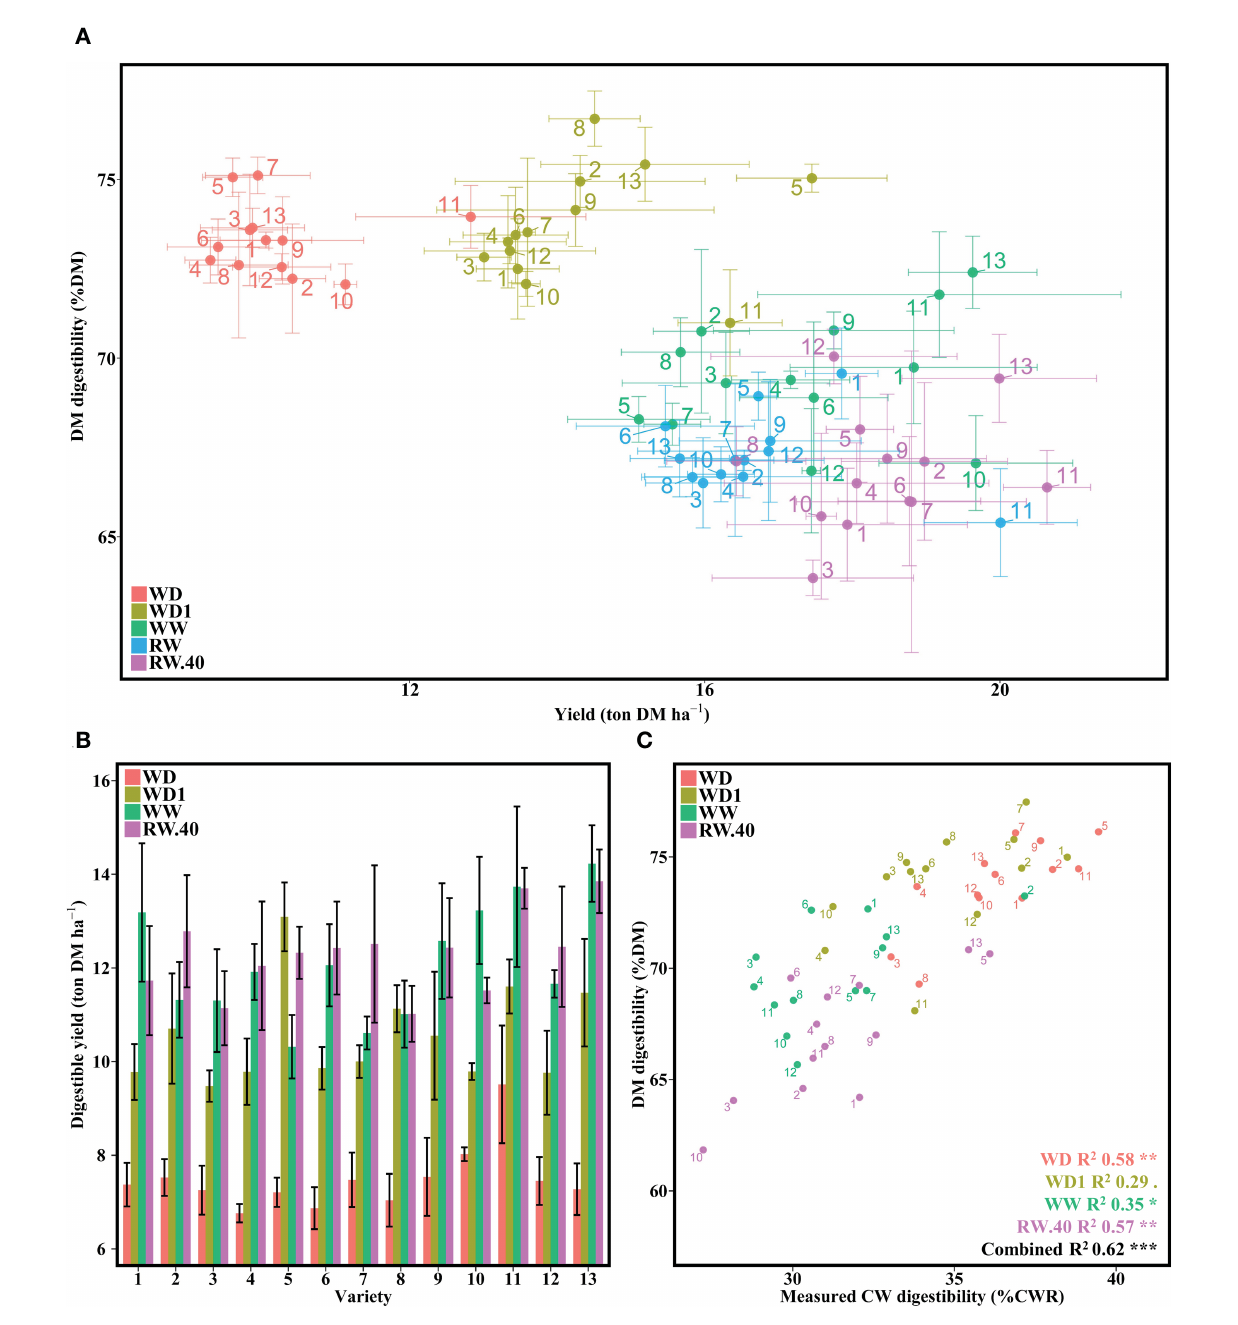
FIGURE 2 Effect of water de fi cit on DM digestibility, its combination with yield, and its relationship to measured CW digestibility. (A) DM digestibility to yield per variety under the fi ve conditions. (B) Digestible tons of DM per ha averaged per condition for each variety under four conditions. (C) Relationship between laboratory measured DM digestibility and measured CW digestibility on a single representative block. Bars represent means and error bars represent standard error margins. Linear equation values are proceeded by Pearson correlation signi fi cance symbols: P <0.1:.; P <0.05: *; P <0.01: **; P <0.001: